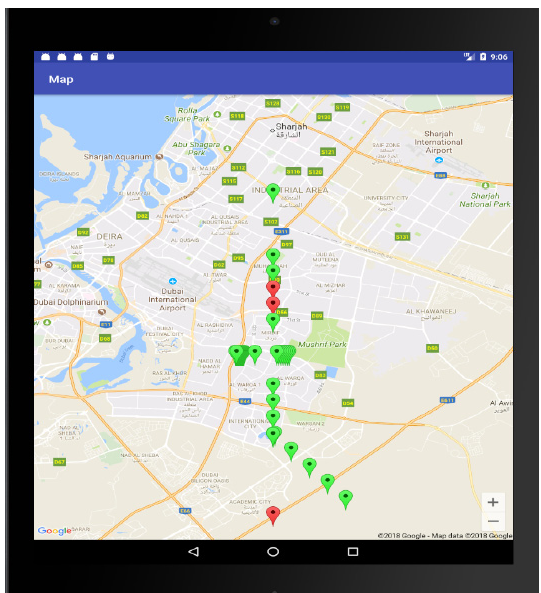
Figure 7. Testing scalability: around 99 bus stops.